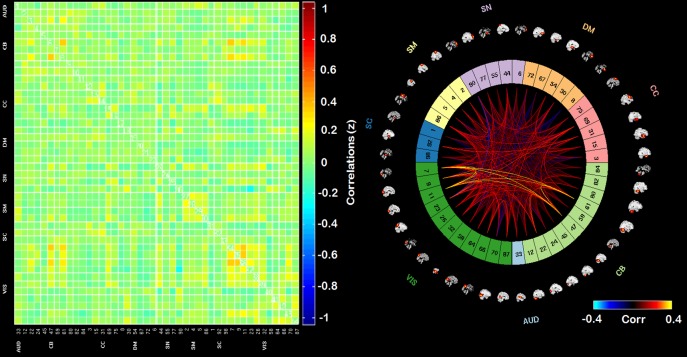
Adjacency matrix and connectogram highlighting the connectivities across subnetworks for state 3.Abbreviations: Aud: auditory network, ECN: executive control network, DMN: default mode network, SM: sensory-motor network, SN: salience network.